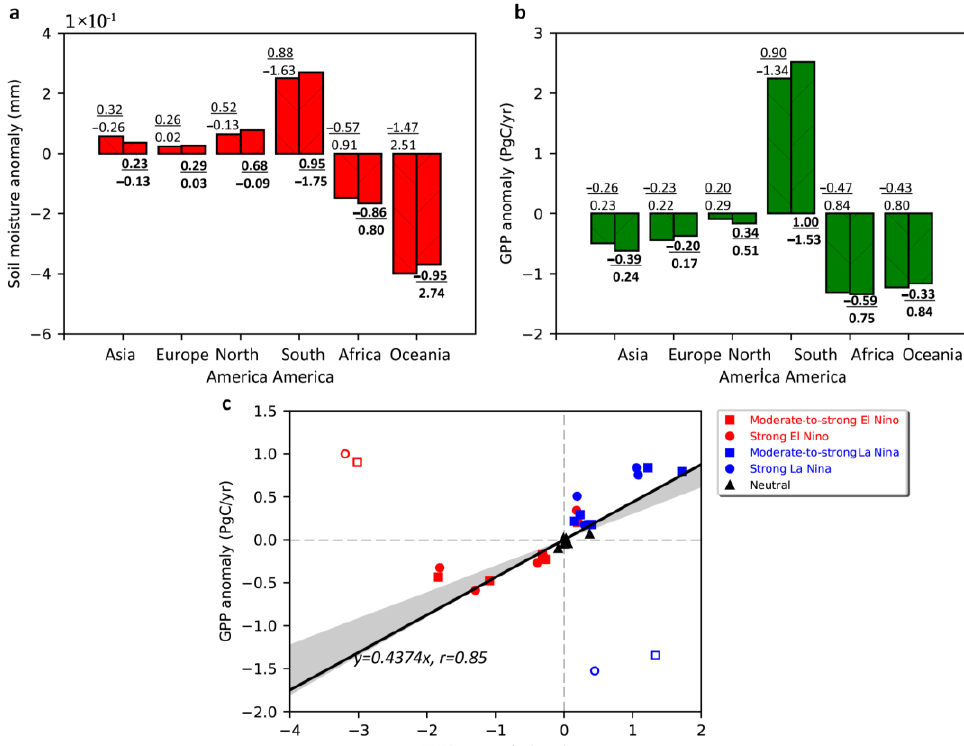
Figure 4. Continentally aggregated soil moisture ( a ), GPP ( b ) anomaly differences during El Niño/La Niña period, and ( c ) the GPP relation to TWS from GRACE-REC. Hatches in the bars with slash and backslash denote results during aggregated moderate-to-strong El Niño/La Niña event periods and during aggregated strong El Niño/La Niña event periods, respectively. Values next to each bar denote the anomalies during aggregated El Niño (up) and La Niña (down) event periods, respectively. Symbols in ( c ) denote aggregated GPP and GRACE-REC TWS anomalies for different levels and types of El Niño/La Niña events in each continent. The regressions (black line) are based on the solid dots. The empty dots denote data from South America during different El Niño/La Niña events.